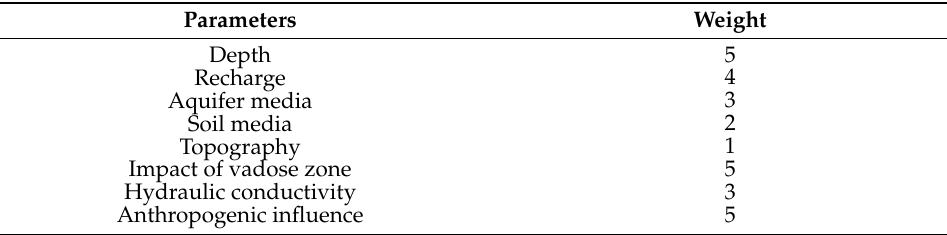
Table 1. Assigned weights for DRASTIC parameters (Source: [9]) and DRASTICAI.